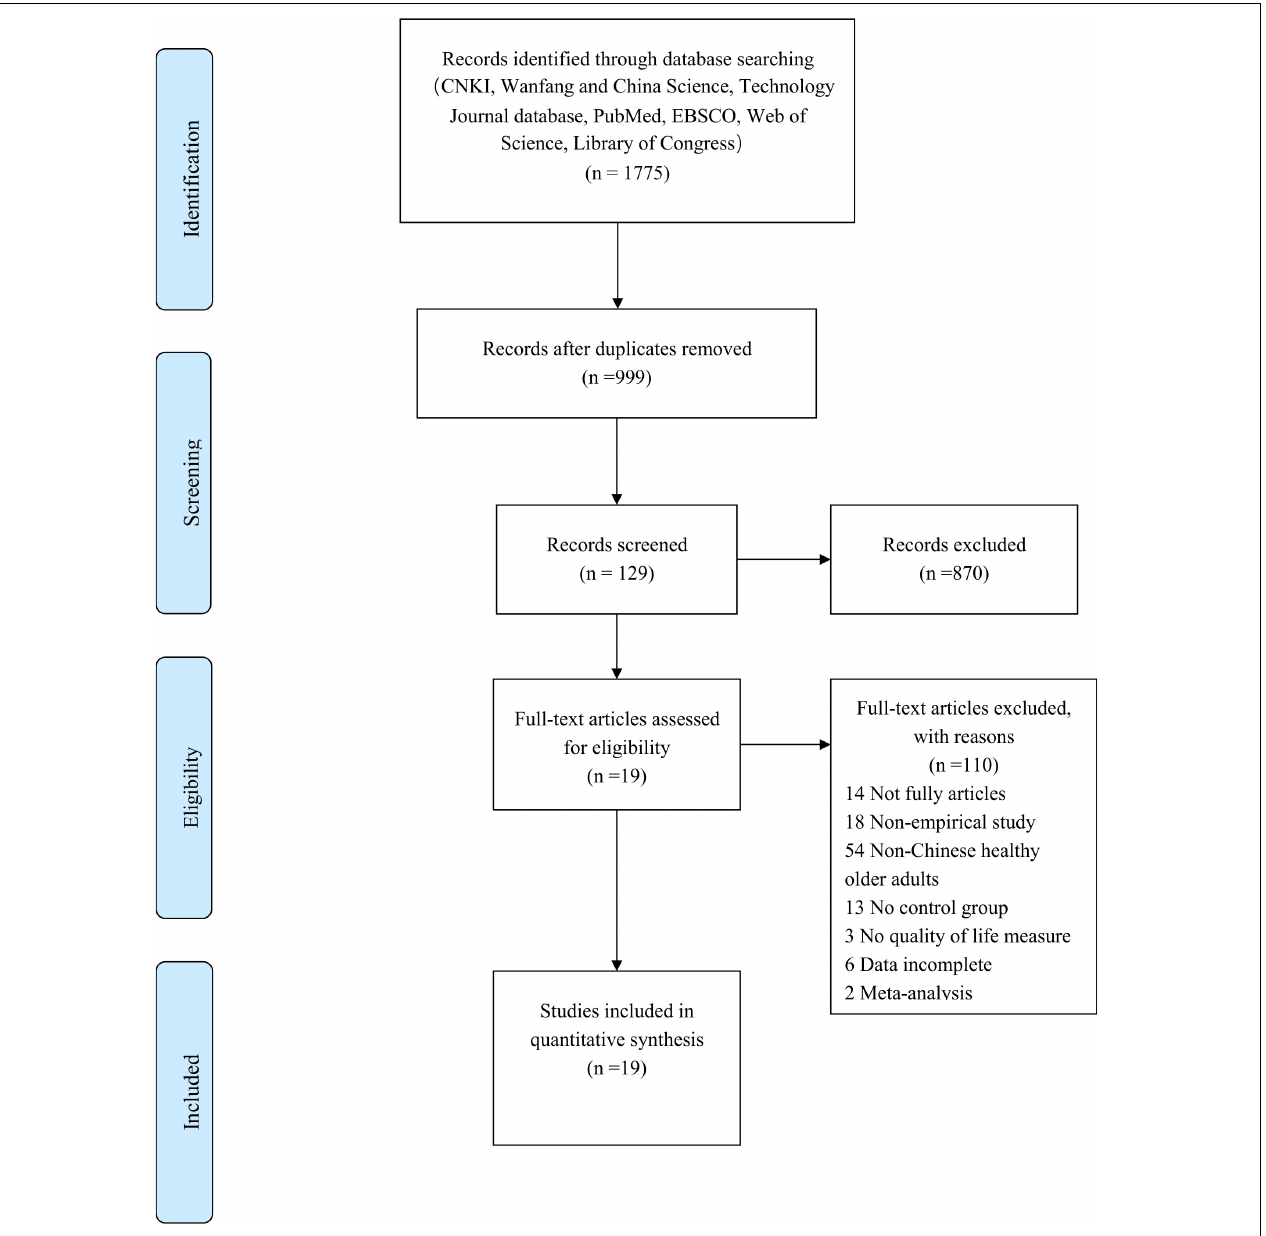
FIGURE 1 | Article selection